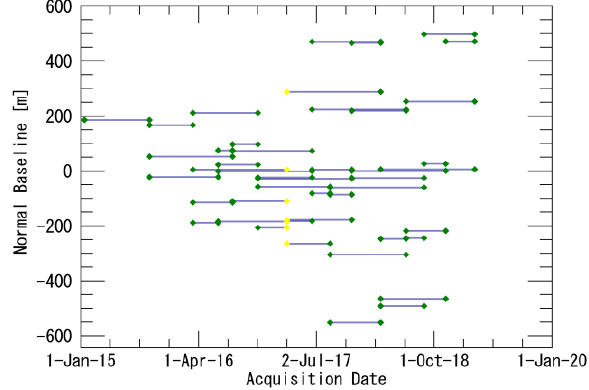
Figure 4. Temporal and spatial baseline distribution of the SAR interferogram acquired from ALOS-2 PALSAR-2